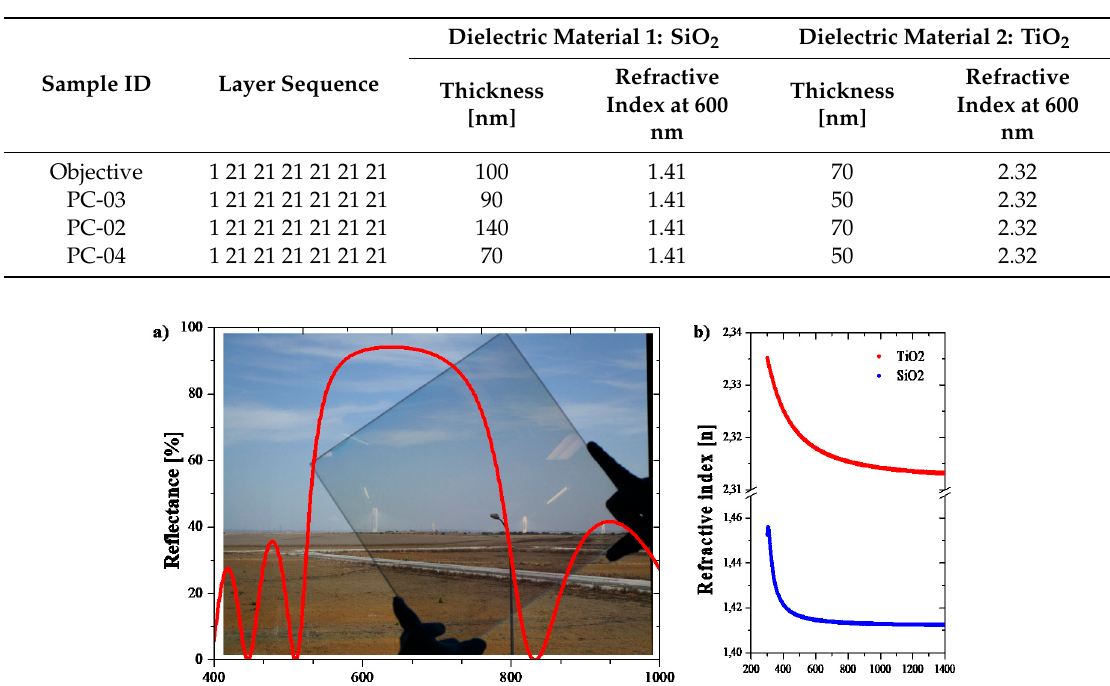
Table 1. Properties of 1DPC fabricated during calibration process.